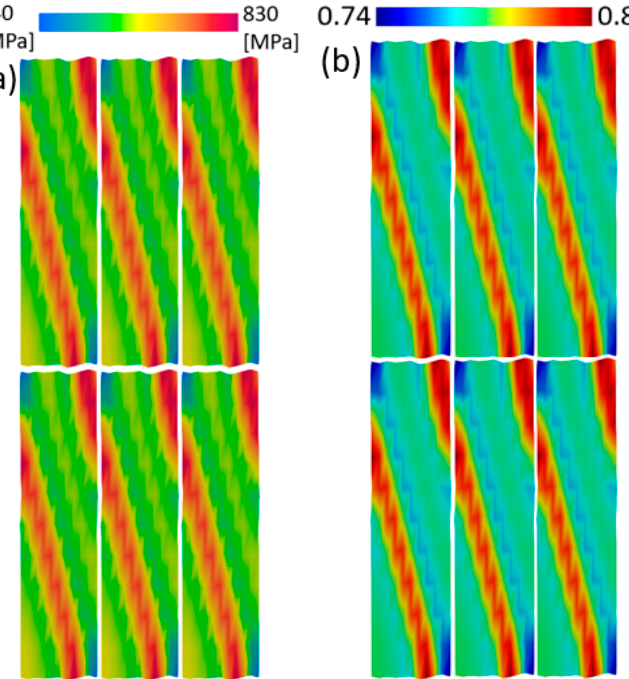
Figure 5. The distribution of ( a ) equivalent stress and ( b ) equivalent plastic strain of 6 cells in the infinite medium at ε n = 1.0 when ∅ = 60 ◦ .